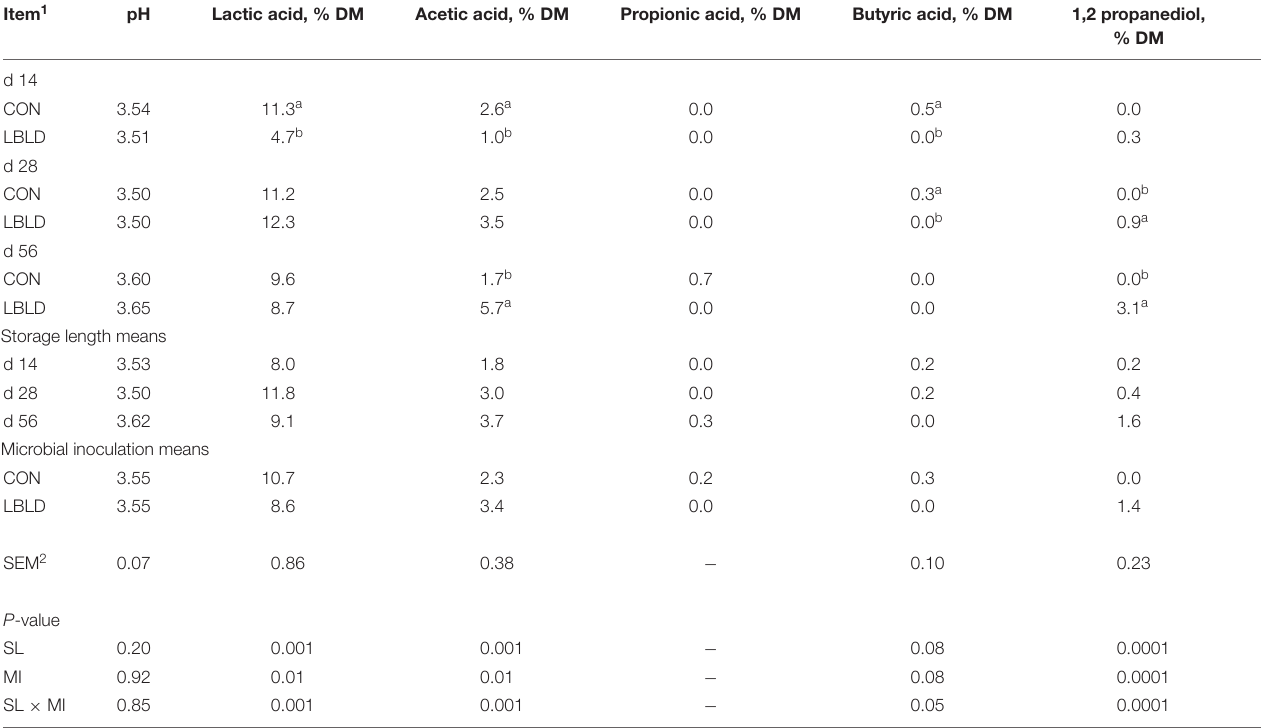
TABLE 4 | Effect of microbial inoculation and storage length on the fermentation profile of whole-plant forage sorghum silage in experiment 2. Item 1 pH Lactic acid, % DM Acetic acid, % DM